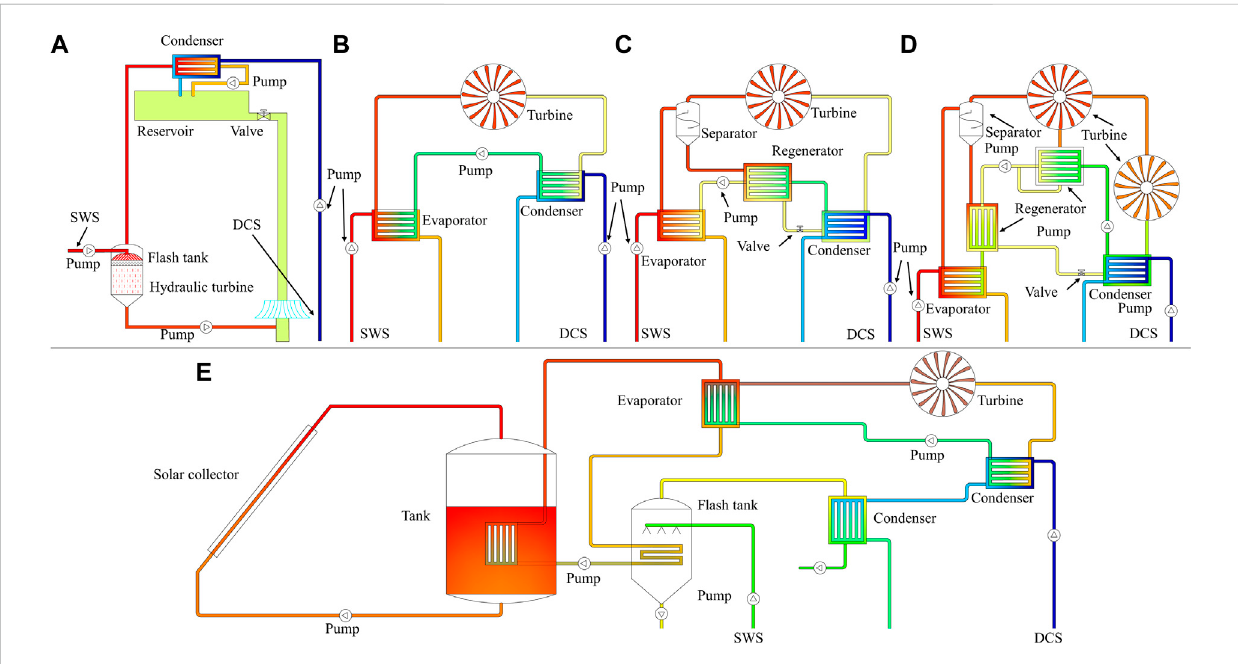
FIGURE 1 Different forms of cycle in OTEC power generation: (A) mist fl ow OTEC plant (Ridgway, S.L., 1977), (B) organic Rankine cycle, (Cao, H., 2010), (C) Kalina cycle (Kalina, A. I., 1984), (D) Uehara cycle (Uehara, H., 1998), and (E) hybrid solar – OTEC system (Park, S.,